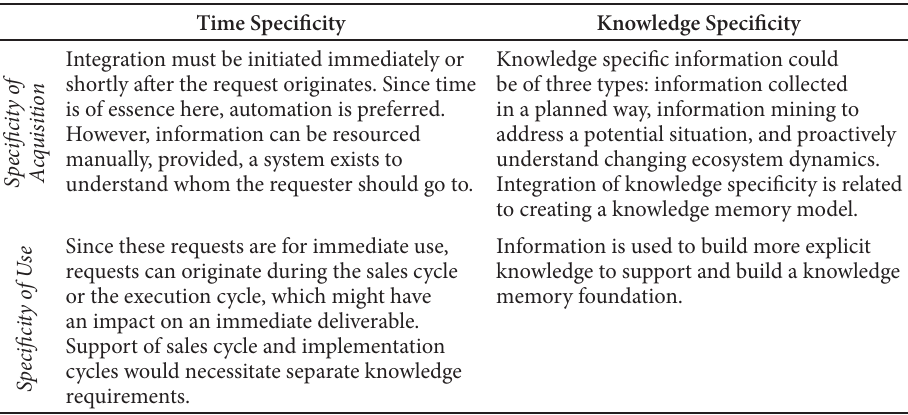
Table 1. The specificity of information Time